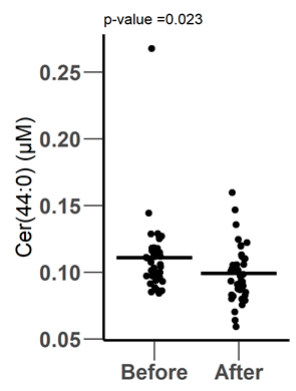
Figure 5. Differentially expressed Ceramides before and after surgery, as measured by LC-MS using the biocrates P400 kit.